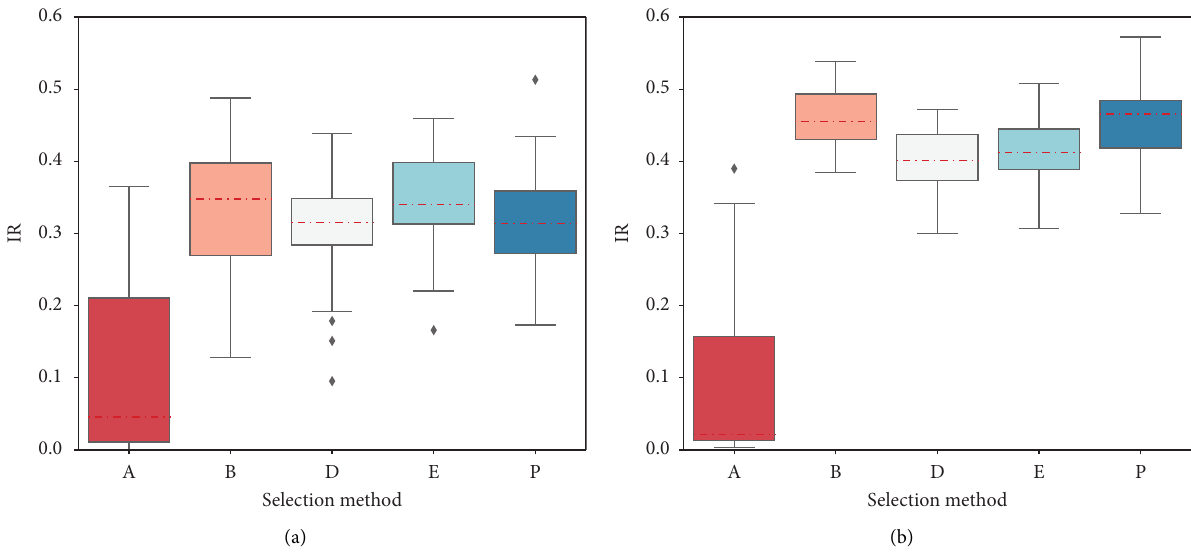
Figure 6: In L-Space for (a) STAR and (b) AVL, CFL, RGTR, and TICE networks. pI � 0.05, pR � 0.0025, and T � 65 (boxplot diagram for A, B, D, E, and P